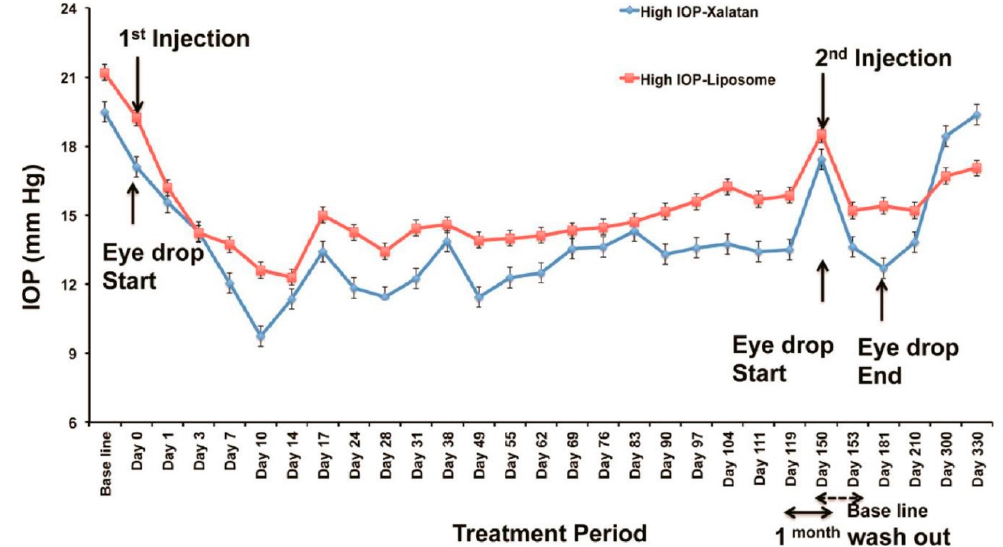
Figure 5. Comparative analysis between Xalatan eye drops and Latanoprost-loaded liposomes administered via the subconjunctival route in nonhuman primates. A great reduction of intraocular pressure was observed when a single injection of Latanoprost-loaded liposomes was done via the subconjunctival route for a period of 120 days in comparison with Xalatan eye drops. After a second injection, the intraocular pressure reduced further over another period of 180 days. Reproduced from [47] with permission from the American Chemical Society.